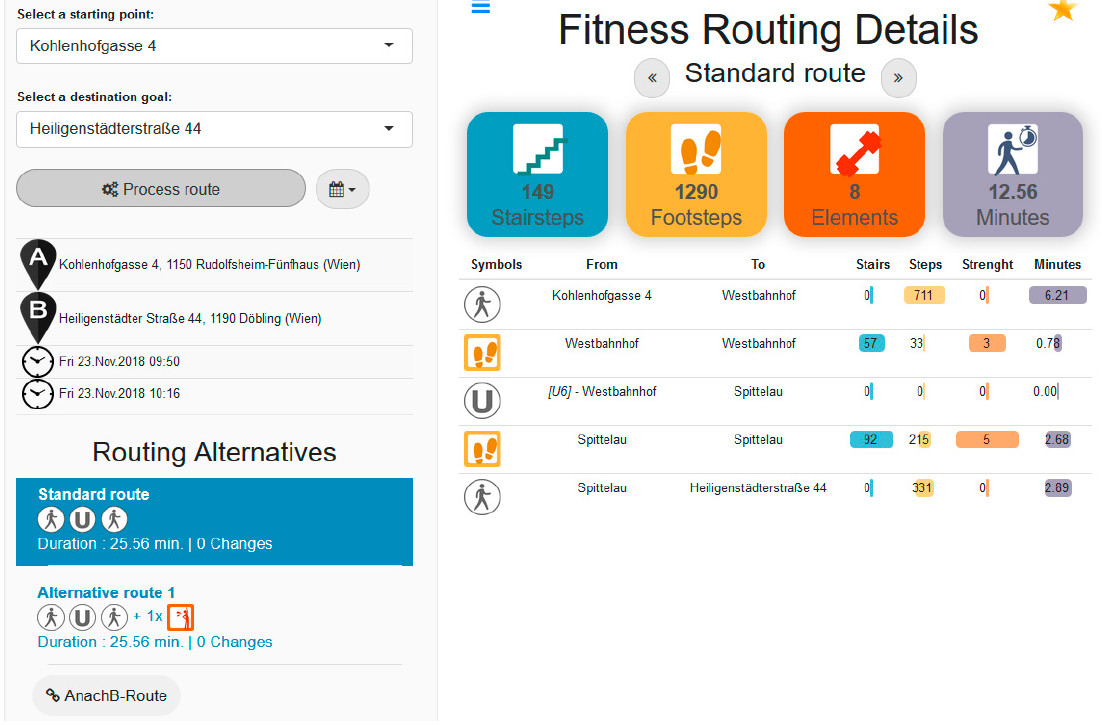
Figure 1. Routing area of the fitness feedback demonstrator. Visualization by TraffiCon GmbH, Salzburg. Soc. Sci. 2019 , 8 , x FOR PEER REVIEW